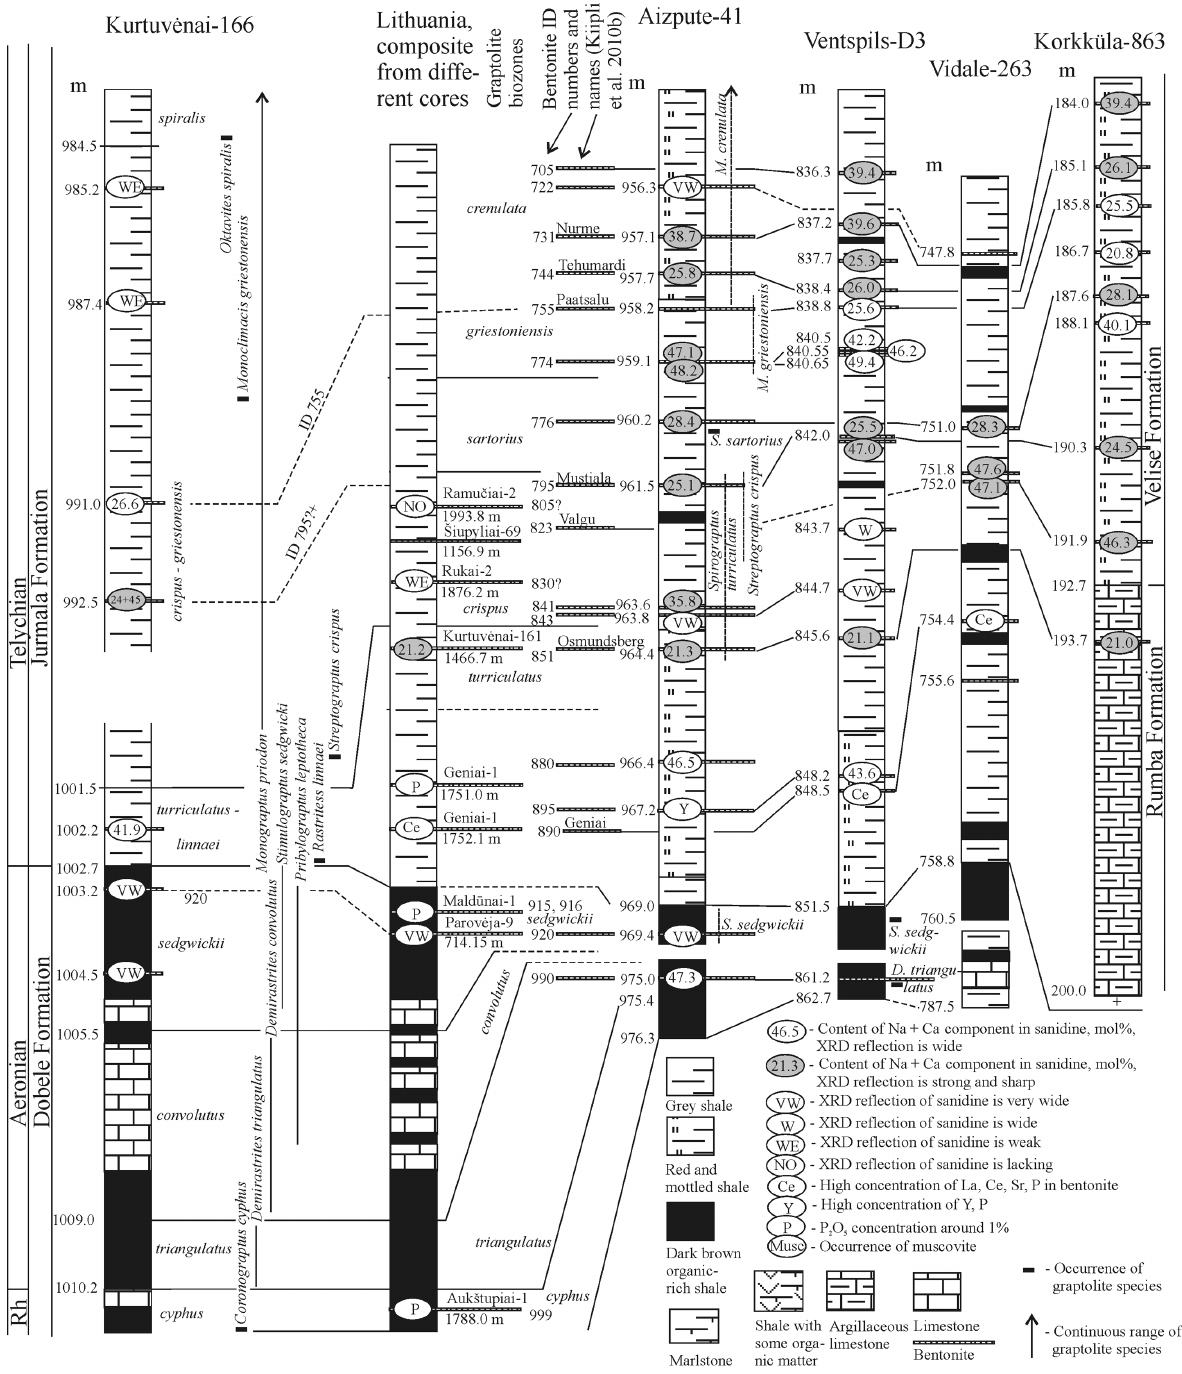
Fig. 4. Correlation of bentonites in the Rhuddanian (Rh), Aeronian and lower Telychian. Distribution of graptolites in the Ventspils-D3 core from Gailite et al. (1987) and in the Aizpute-41 core from Loydell et al.